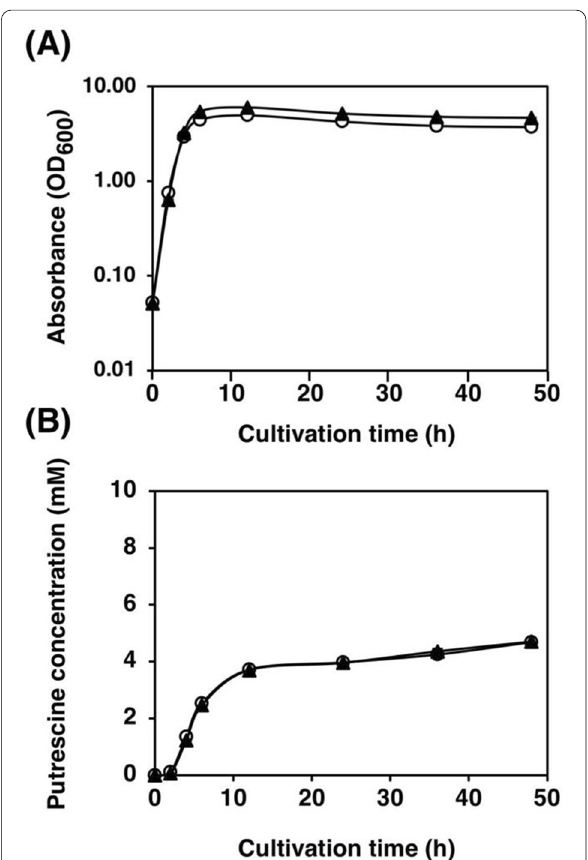
Fig. 5 Effects of promoters of speAB and desensitized argA on putrescine production. A Bacterial cell growth and B putrescine concentration in the supernatant of strains KT37 ( lacI promoter, closed triangle), KT38 ( lacI q promoter, open circle), KT39 ( lacI q1 promoter, closed square), and KT148 (T5 promoter, open diamond) grown in LB medium supplemented with 100 μg/mL of ampicillin. When the OD 600 reached 0.4, 0.02 mM IPTG was added. Data shown are averages standard deviations, and culture experiments were ± performed in